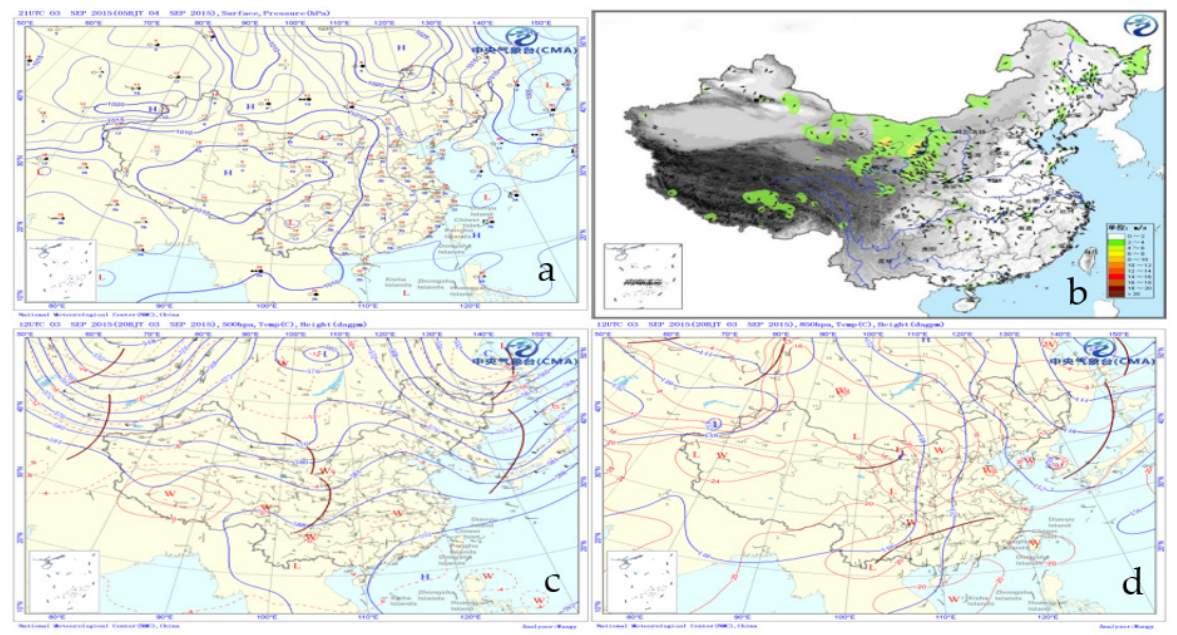
Figure 5. Maps of the weather and AQI situation at 07:00 on 3 September in 2015. Notes: ( a , c , d ) shows the map of the surface, 500 hPa height, 850 hPa height, respectively. ( b ) shows the automatic ground observation of 1 h wind field at 07:00 on 3 September in 2015.